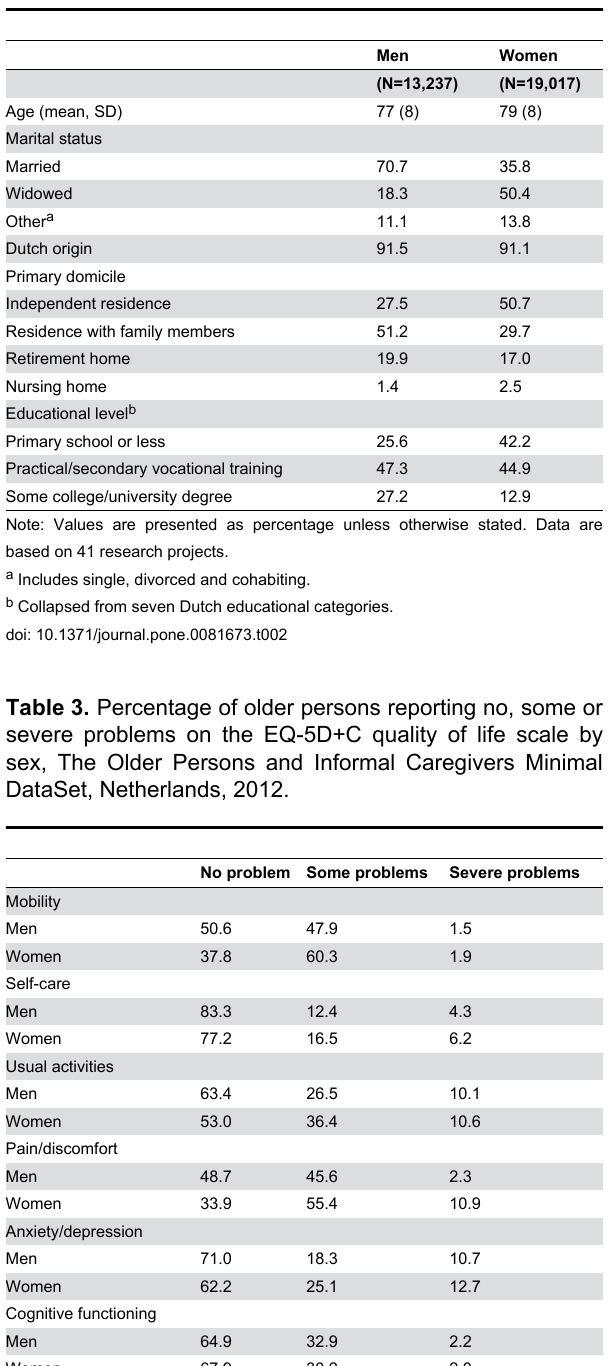
Table 2. Demographic characteristics of older persons, The Older Persons and Informal Caregivers Minimal DataSet, Netherlands, 2012.